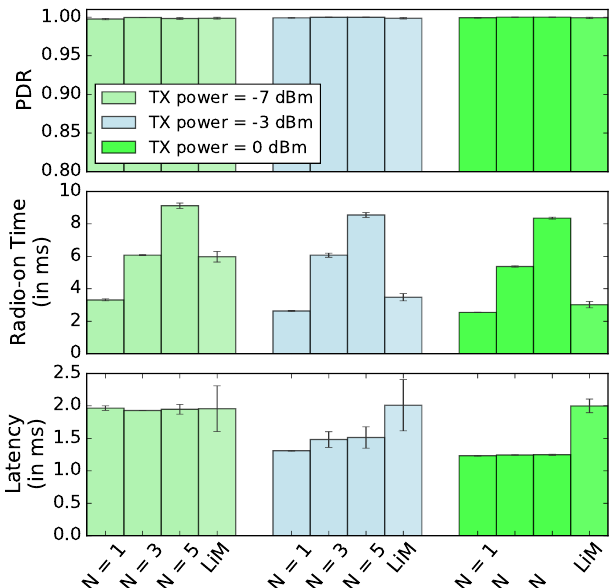
Figure 8. Performance metrics of Glossy with various N values and of LiM, respectively. Both protocols set node 1 as the initiator and use the transmission power of -7, -3, and 0 dBm. LiM inherits the advantages from Glossy in terms of high reliability with various levels of transmission power, while effectively reducing the radio-on time. The longer latency in LiM stems from the overall processing time in the bandit-learning phase. Figure 8 revels the performance comparison between